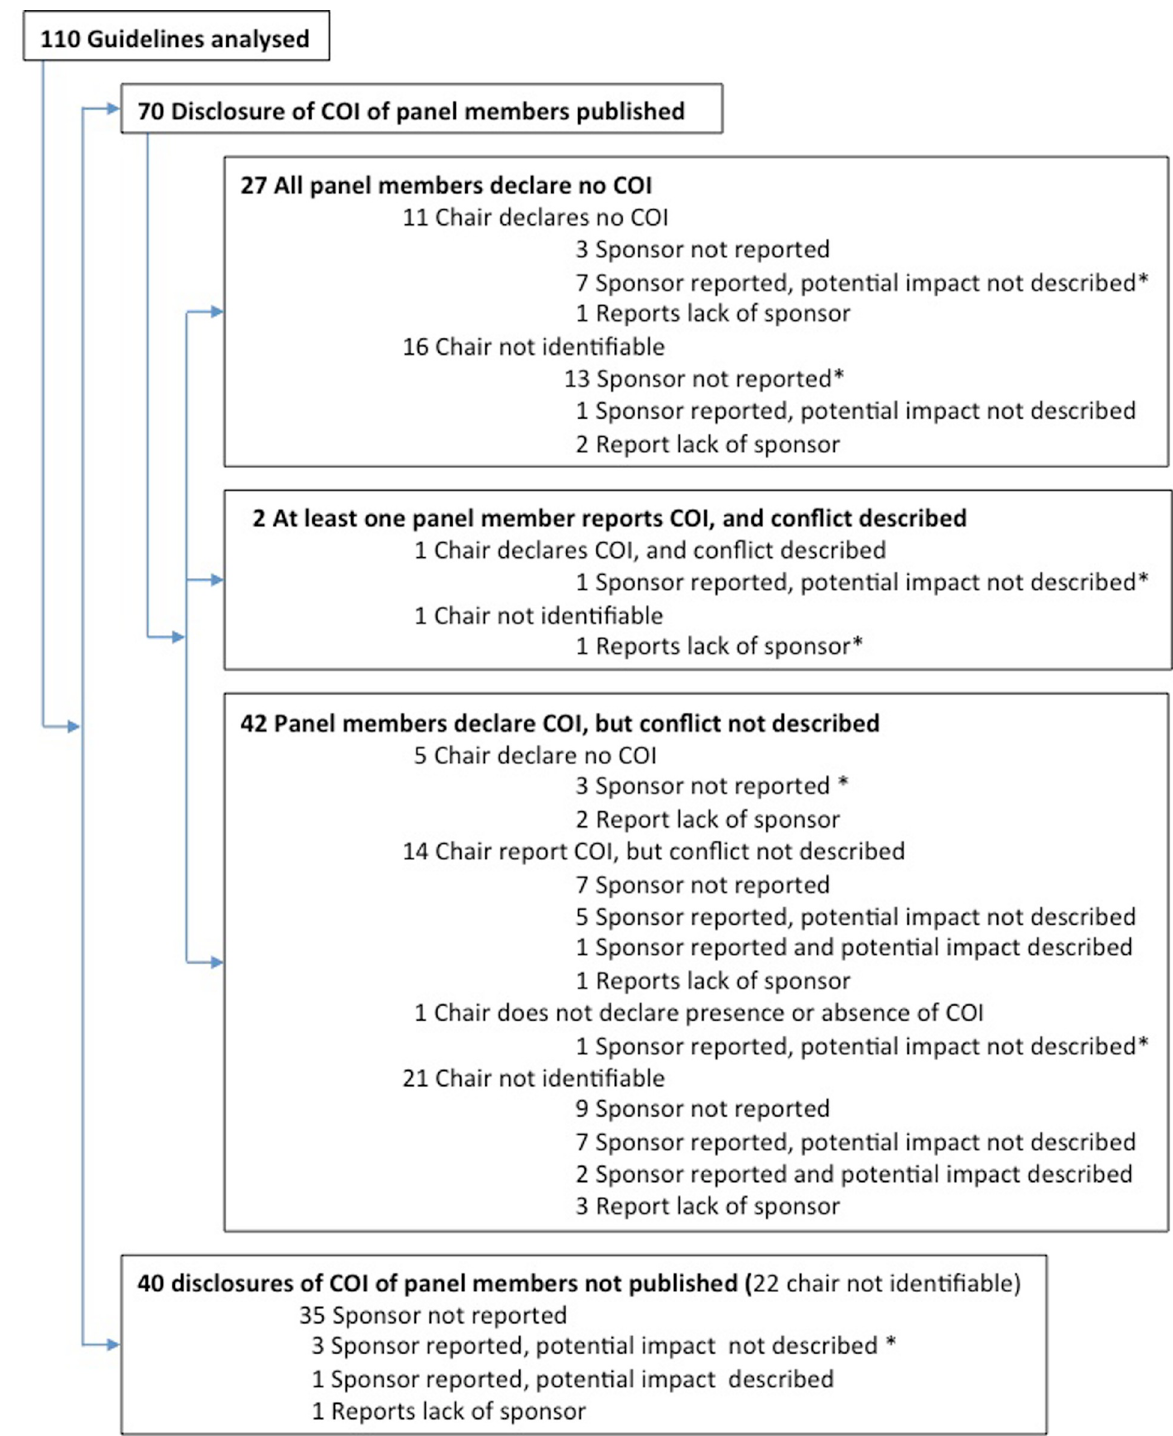
Fig 2. Disclosures of conflict of interest of panel members and chairs and sponsorship of guidelines. COI: conflict of interest; � Guidelines describing how COI were managed.